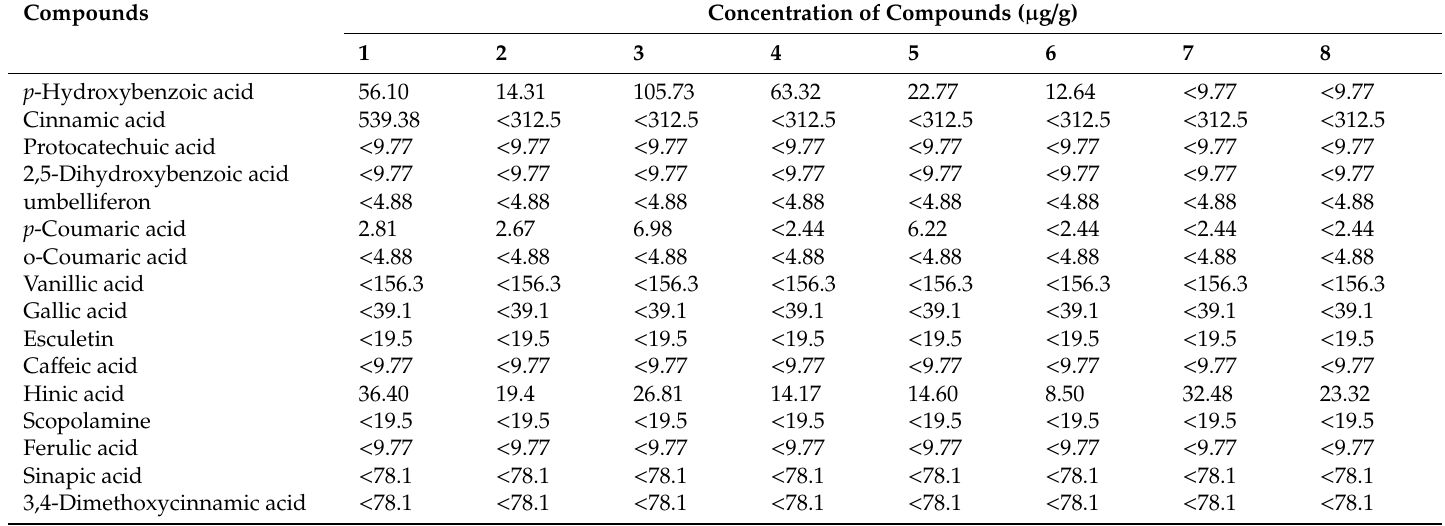
Table 3. Chemical composition of the tested mushroom